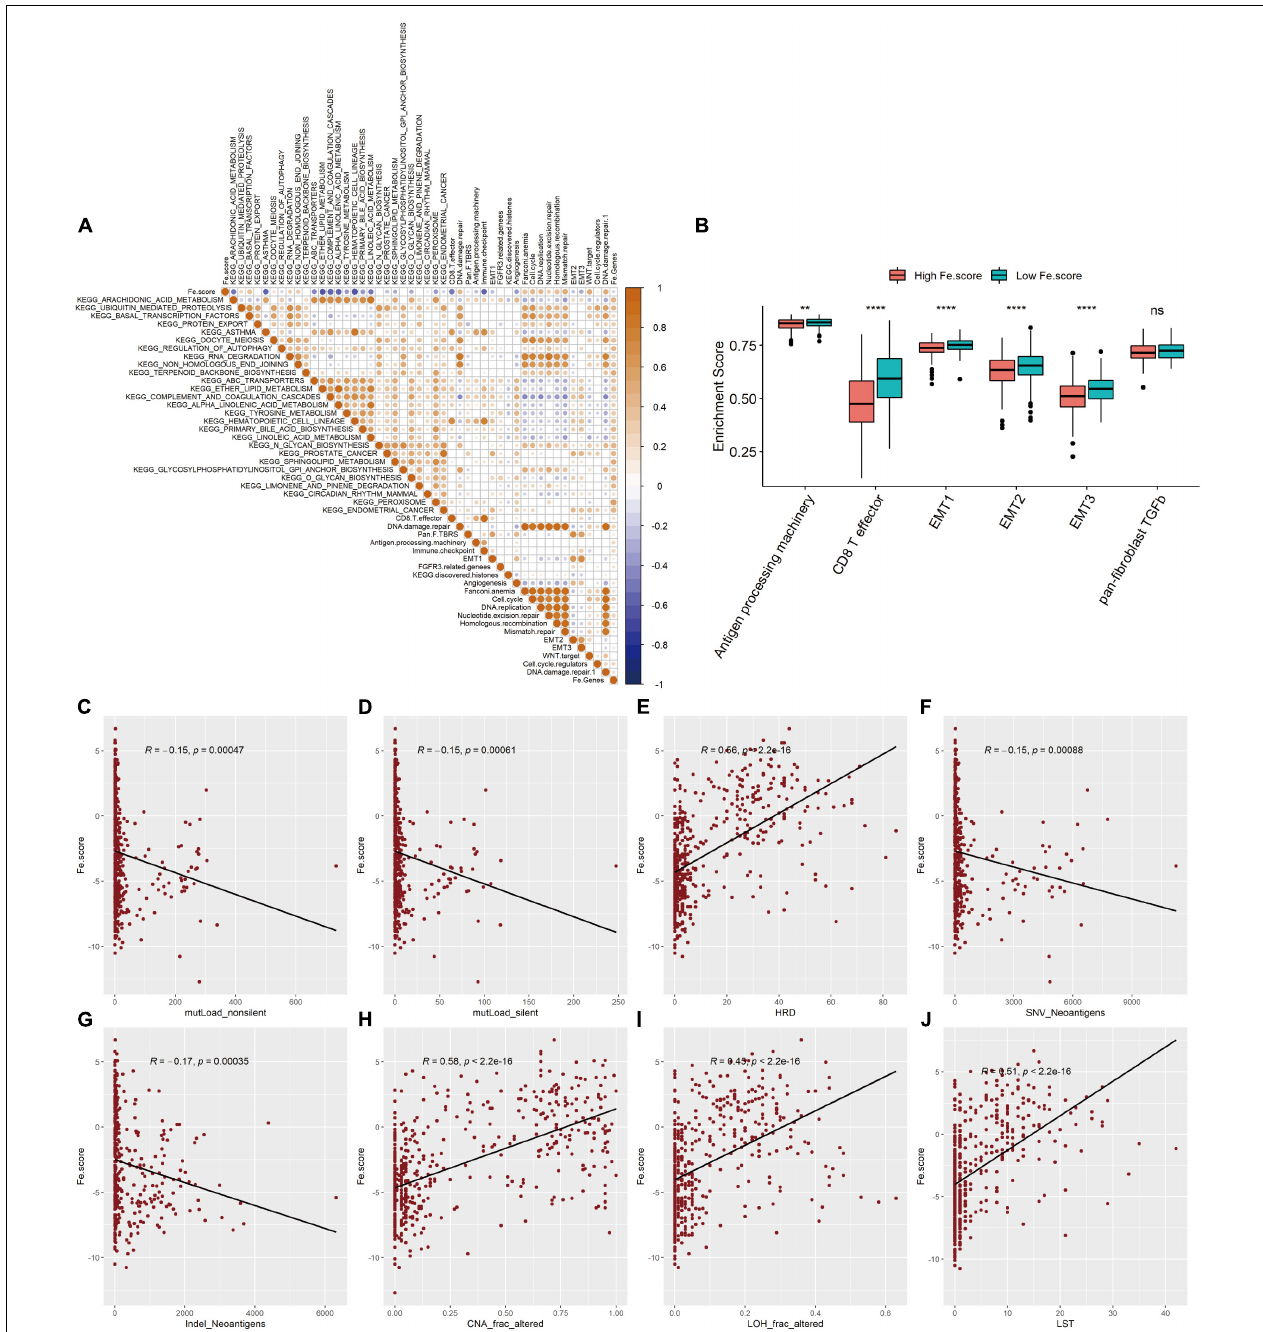
FIGURE 6 | Correlation between ferroptosis score and molecular characteristics. (A) Correlation diagram between Fe.score and differential enrichment pathways. The color depth represents the degree of correlation: yellow represents a positive correlation, and blue represents a negative correlation, and white represents irrelevance. The size of the dot indicates the degree of correlation; the greater the absolute value of the correlation, the larger the point. p -Value < 0.01. (B) Differences in the enrichment scores of related biological processes among the Fe.score groups. (C) Correlation between Fe.score and mutLoad_nonsilent. (D) Correlation between Fe.score and mutLoad_silent. (E) Correlation between Fe.score and HDR. (F) Correlation between Fe.score and SNV_Neoantigens. (G) Correlation between Fe.score and Indel_Neoantigens. (H) Correlation between Fe.score and CNA_frac_altered. (I) Correlation between Fe.score and LOH_frac_altered. (J) Correlation between Fe.score and LST. MutLoad_nonsilent and mutLoad_silent indicate TMB, SNV_Neoantigens and Indel_Neoantigens indicate neoantigen load, and CNA_frac_altered, LOH_frac_altered, and LST indicate the level of chromosomal instability. ** p < 0.01 and **** p < 0.0001.